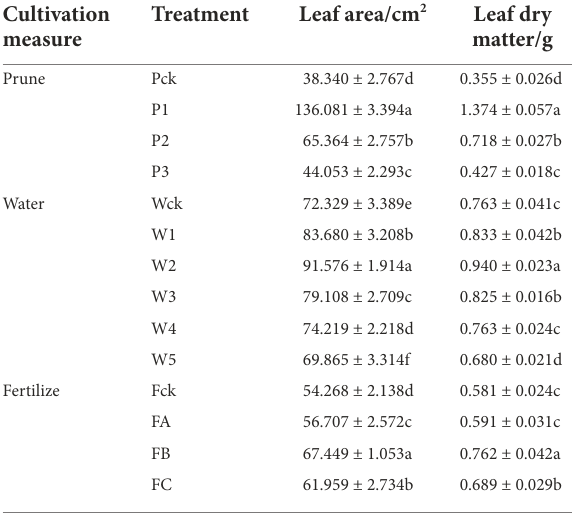
TABLE 1 Morphological change in leaves under different